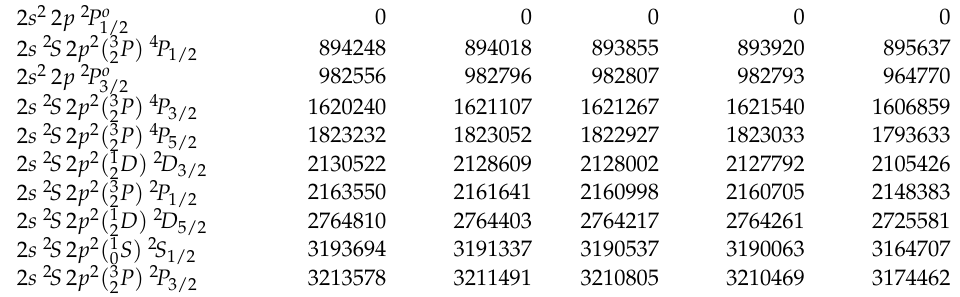
Table 9. Energies in cm − 1 from the files energy3, energy4, energy5, energy6,